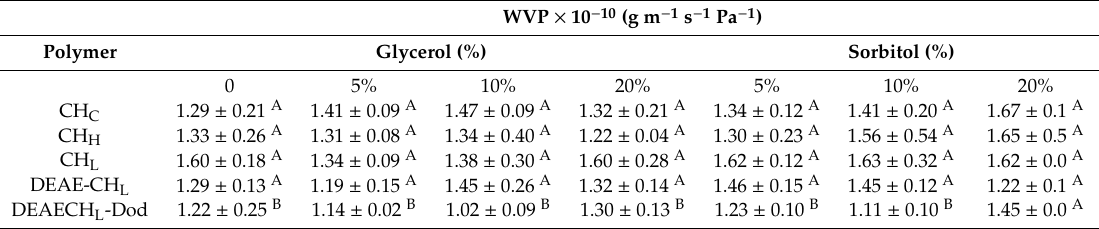
Table 4. Average water vapor permeability of chitosan films prepared with increasing percentages of glycerol and sorbitol at a relative humidity of